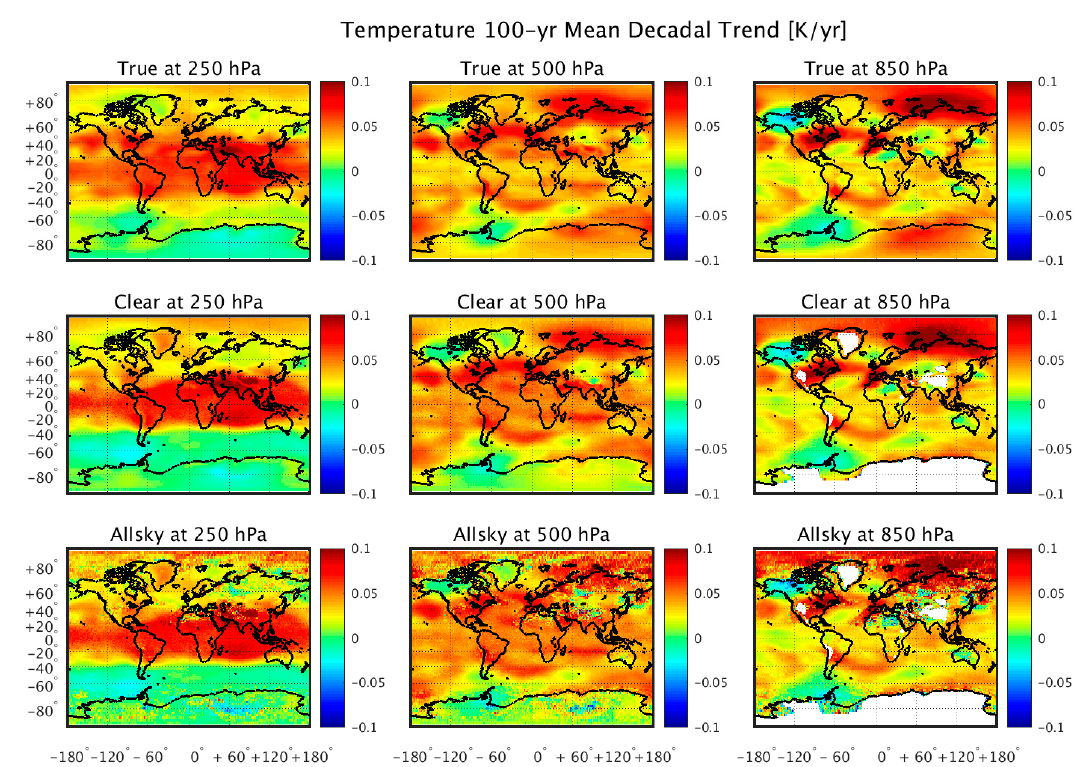
Figure 4. Examples of comparisons between the 100-year regional trends in atmospheric temperature (K / year) produced by a climate model simulation (top row) with 100-year trends throughout the twenty-first century retrieved from simulated CLARREO spectral infrared radiance measurements, assuming: clear-sky conditions using a linear regression model trained with contemporary global weather observation atmospheric conditions (middle row); and all-sky conditions using a linear regression model trained with contemporary global weather observation atmospheric conditions (bottom row). These results demonstrate the ability to retrieve regional temperature trend information when averaging over the full 100-year period.